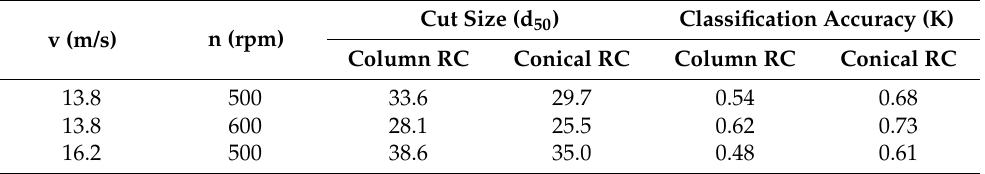
Table 3. Comparison of the cut size (d 50 ) and classification accuracy (K) for the column and conical rotor cage. v